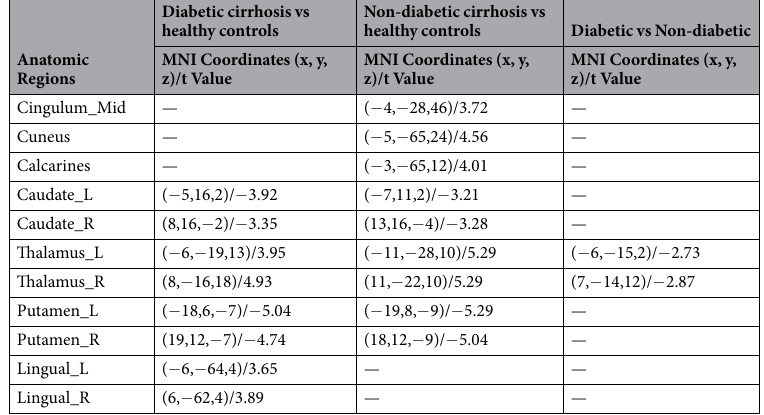
— — Table 2. Differences of VBM among three groups. All P < 0.05, with Alphasim corrected. MNI = Montreal Neurological Institute; Mid = middle;L = left; R =